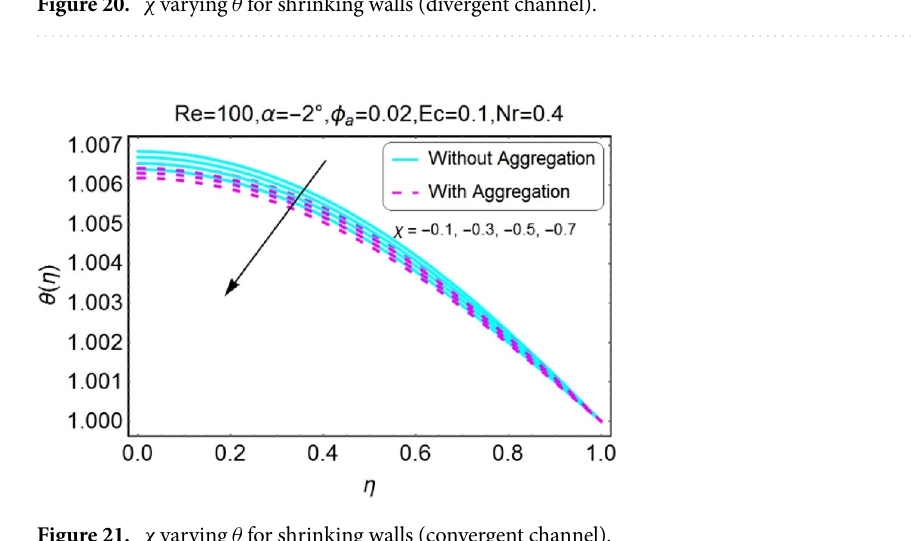
Figure 21. χ varying θ for shrinking walls (convergent